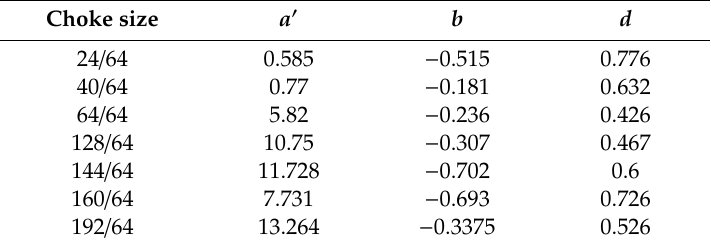
Table 5. Empirical constant and exponents for each individual choke size.